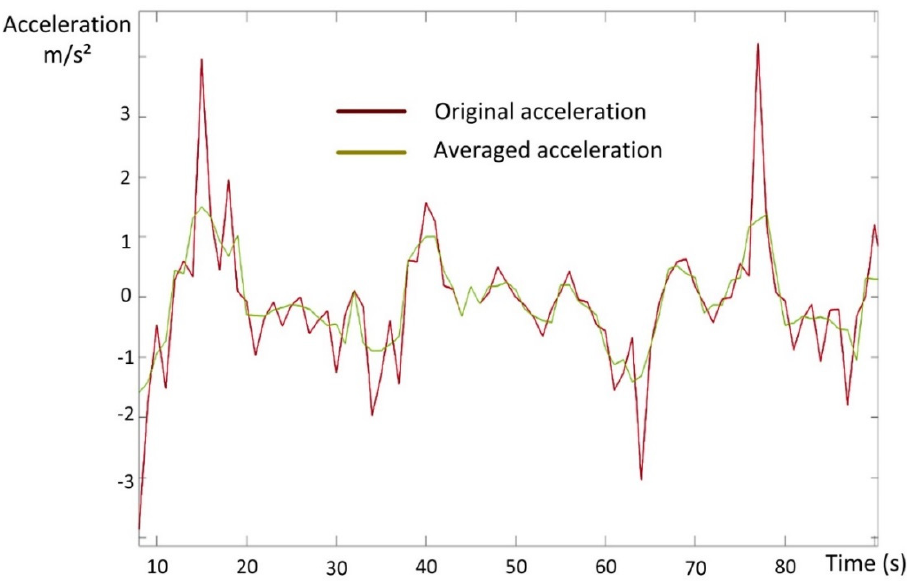
Figure 1. Acceleration and averaged acceleration for a number of data